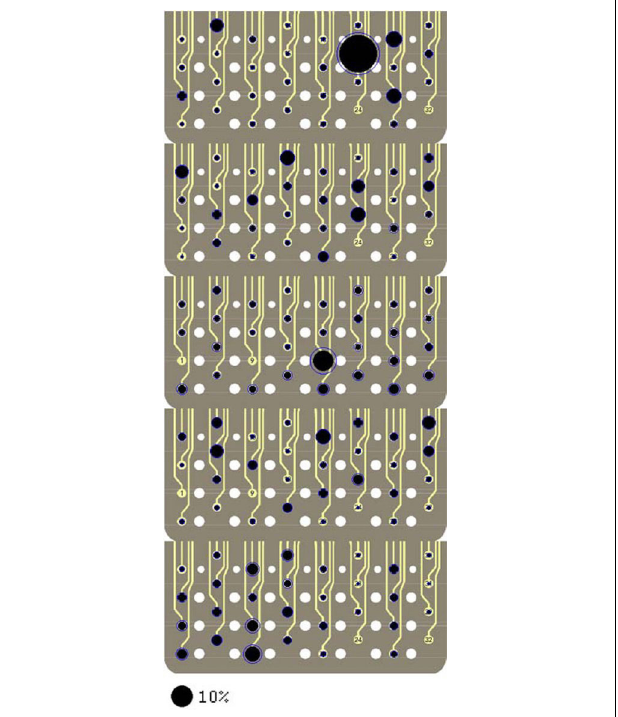
FIGURE 12 | Signal contributions to the vertical force ( Y ) from individual neural channels superimposed on an image of the electrode array for each of the rats R2 through R6 (top to bottom). See Figure 9 caption for further explanation.